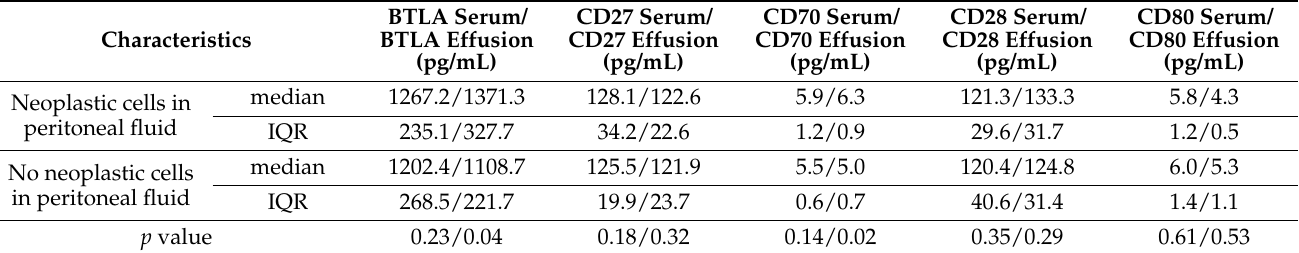
Table 6. Levels of serum and peritoneal fluid concentrations of studied proteins in relation to the presence of neoplastic cells in the peritoneal fluid.